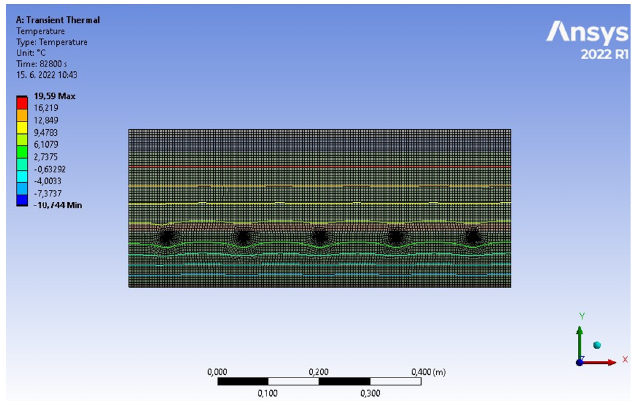
Figure 35. Display of results in the form of isotherms.